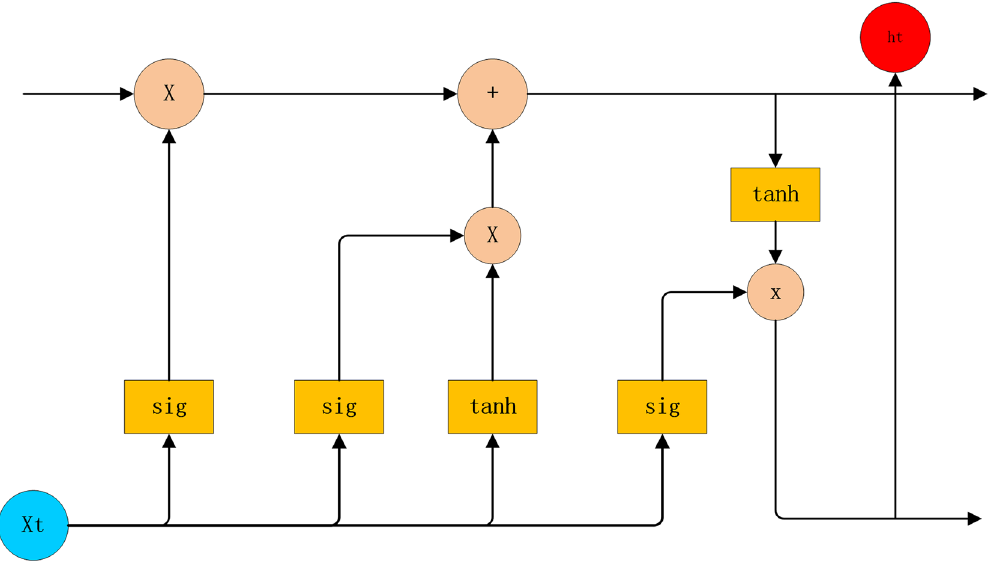
Figure 2. The structure of LSTM (Figure was edited by